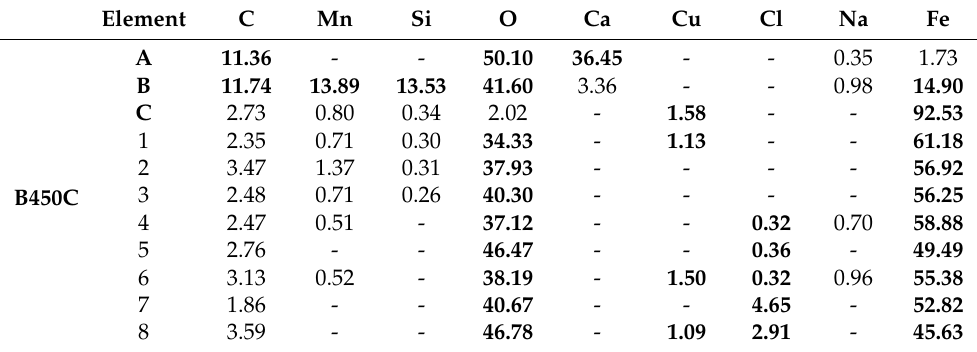
Figure 2. SEM images of B450C carbon steel exposed to a cement extract solution (+5 g L − 1 NaCl): ( a ) a less corroded area and ( b ) a more corroded area after 168 h (7 days); ( c – e ) after 720 h (30 days). Table 5. EDS analysis (wt.%) of the B450C carbon steel surface after exposure to the cement extract solution (+5 g L − 1 NaCl) for 168 h (Figure 2).